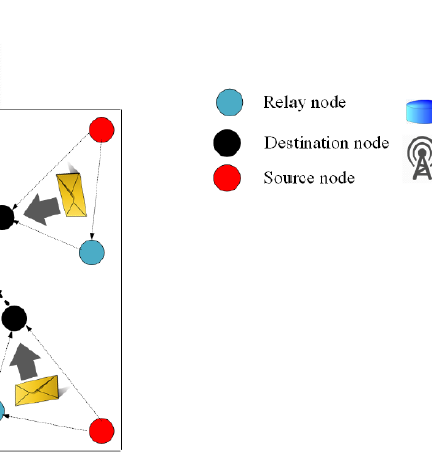
Figure 21. Cooperative routing. CEETHCoR